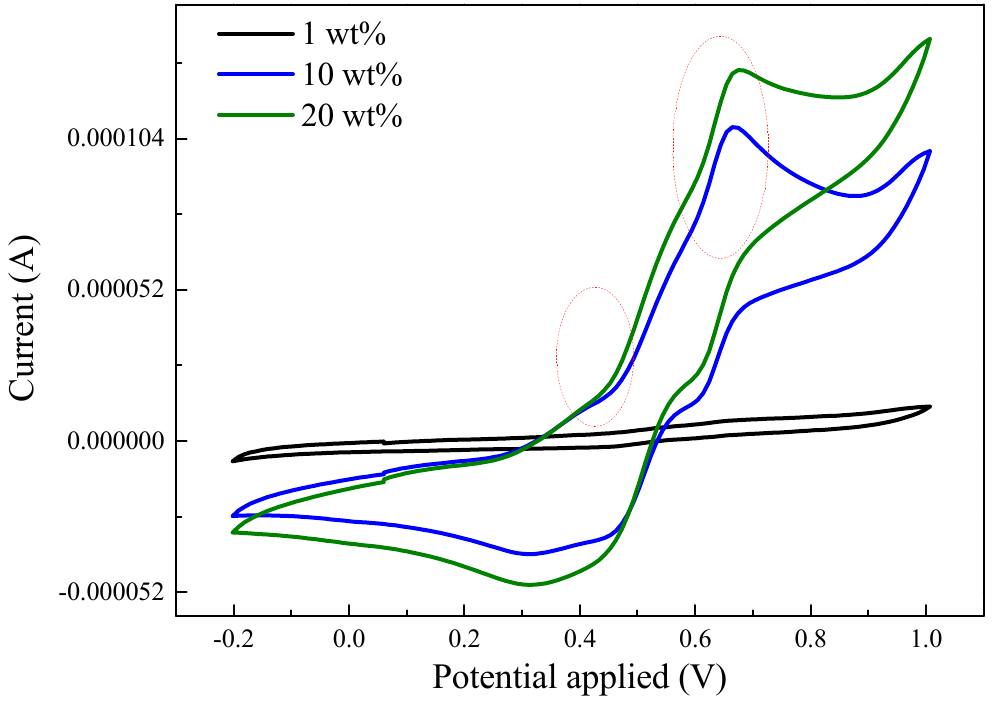
Figure 9. Cyclic voltammetry measurement for S-SEBS polymer with various amounts of TA. The CV test of the composite with 15 wt.% TA and 5 wt.% Fe 3 O 4 shows that there are one weak and one strong peak around 0.2 and 0.65 V, respectively (Figure 10). This result suggests that the addition of Fe 3 O 4 significantly influences the transition from the TA’s leucoemeraldine state to the emeraldine state compared to the transition from the emeraldine state to the pernigraniline state. The Fe 3 O 4 began to affect TA’s transition from the emeraldine state to the pernigraniline state as its expected peak significantly diminished when the Fe 3 O 4 increased to 10 wt.% and TA decreased to 10 wt.%. Moreover, it seems only one pair of redox peaks close to 0.8 and 0.2 V remained when the Fe 3 O 4 amount continually increased to 15 wt.% and TA decreased to 5 wt.%. The oxidation peak and reduction peak for pure Fe 3 O 4 are 0.8 and 0.2 V, respectively, as shown in Figure S4. Therefore, this result indicated that Fe 3 O 4 dominated the CV results for the composite with 5 wt.% TA and 15 wt.% Fe 3 O 4 .